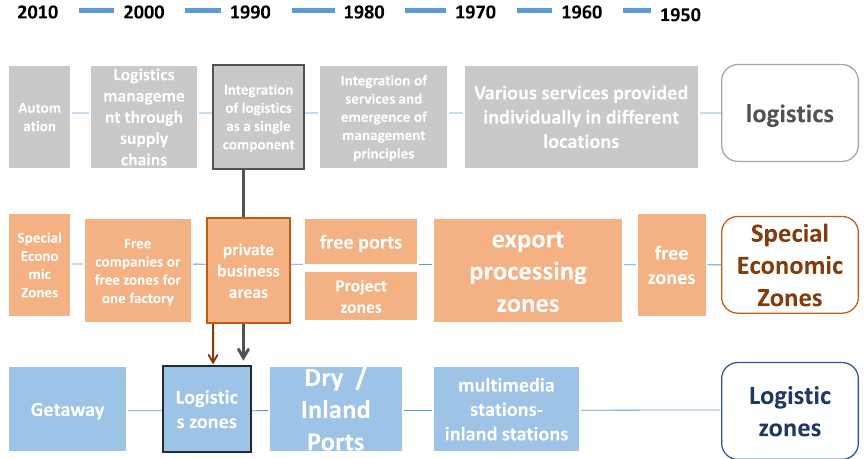
Fig. 1 The origin of logistic zones and its